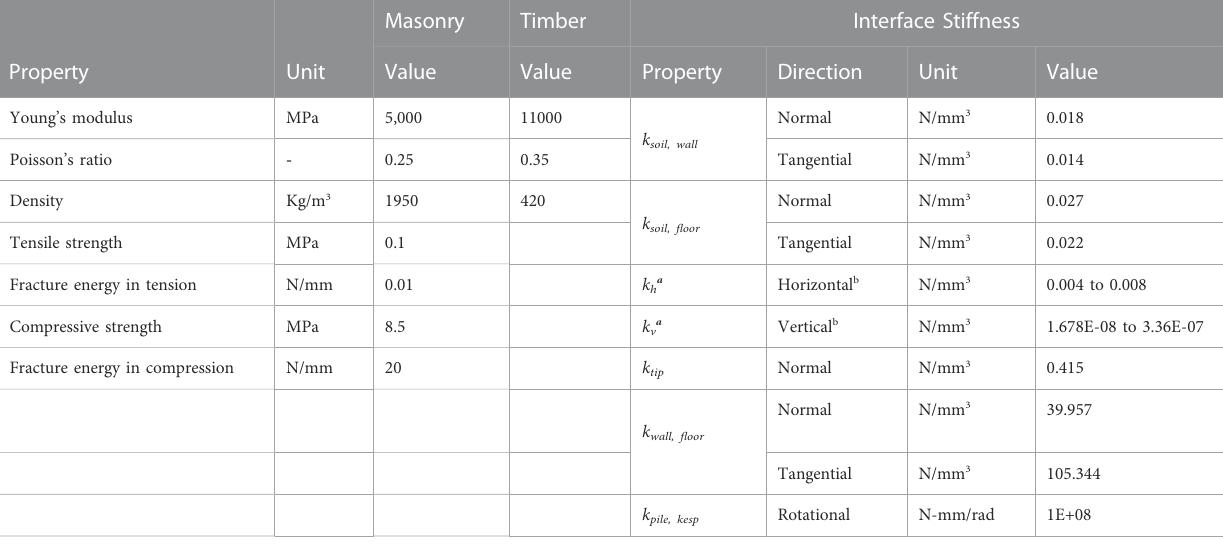
TABLE 1 Summary of material properties adopted in the tier 2 numerical model of Marnixkade